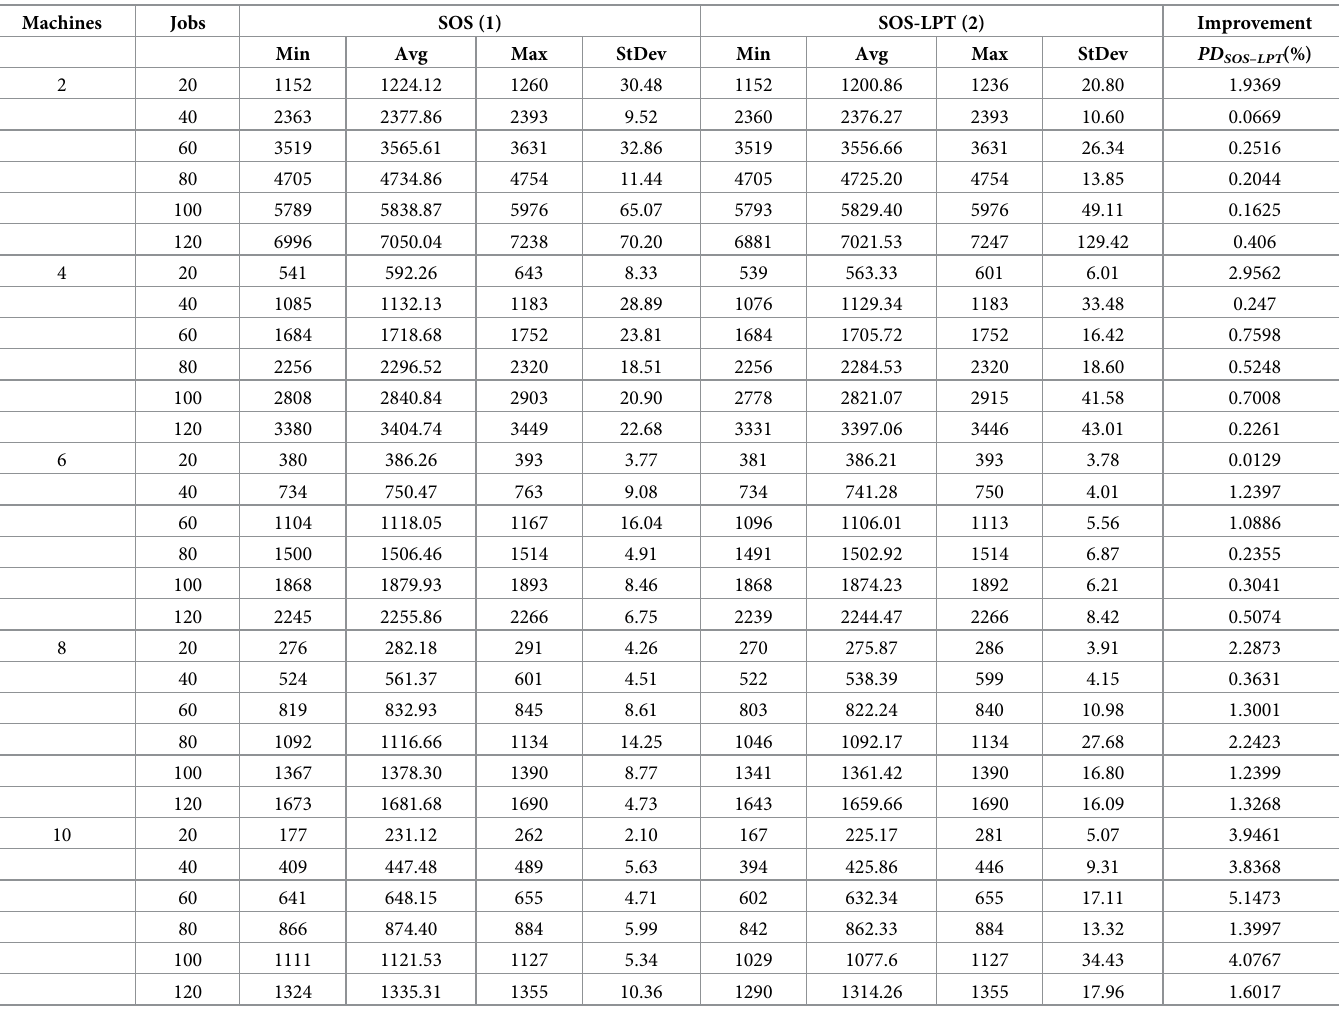
Table 4. Comparison between SOS and SOS-LPT algorithms, with SOS-LPT as the reference algorithm. Machines